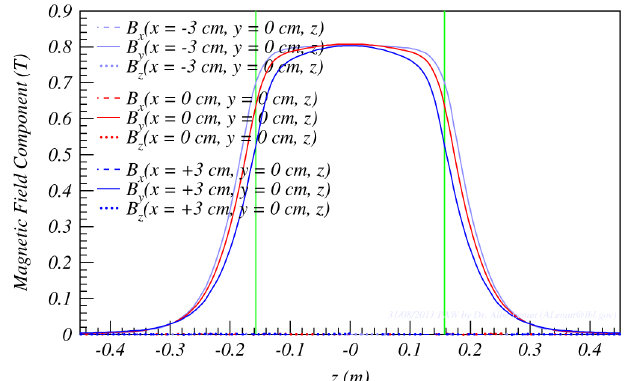
FIG. 10. B x (dashed lines), B y (solid lines), and B z (dotted lines) components of the gas-jet target analyzing magnet calcu- lated by OPERA-3D/TOSCA [21]. Three different trajectory are shown: inner ( x ¼ (cid:1) 3 cm , y ¼ 0 cm , light blue), center line ( x ¼ 0 cm , y ¼ 0 cm , red), and outer ( x ¼ (cid:1) 3 cm , y ¼ 0 cm , blue). The B x and B z values are very close to zero, and therefore overlap with each other. The vertical green lines represent the magnet pole-face to pole-face extension along the center-line